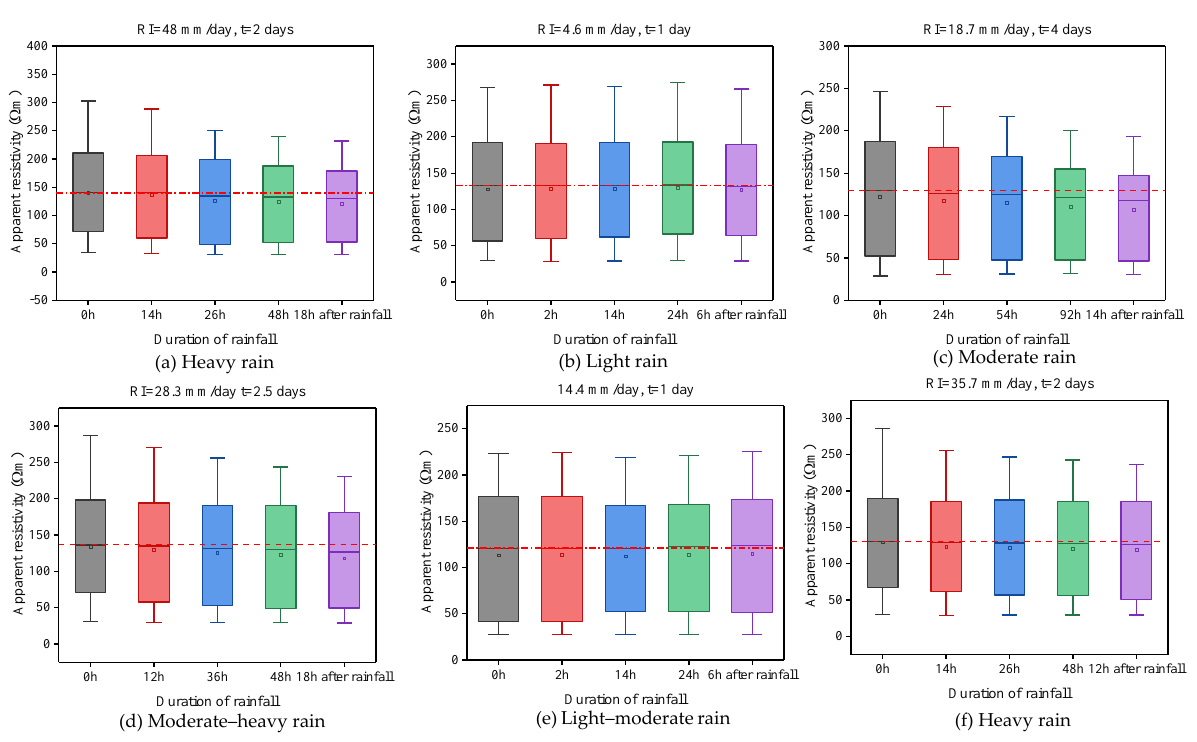
Figure 6. Spatial variability of apparent resistivity of the slope under different rainfall scenarios. The red dashed lines represent mean apparent resistivity for all points ( n = 2769) before the rainfall. The red dotted lines indicate the average measured value for the apparent resistivity of the slope back- ground.